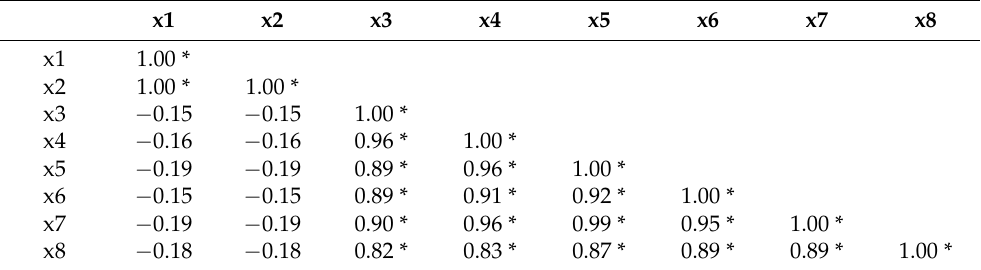
− 0.15 − 0.15 0.89 * 0.91 * 0.92 * 1.00 * x7 − 0.19 − 0.19 0.90 * 0.96 * 0.99 * 0.95 * 1.00 * x8 − 0.18 − 0.18 0.82